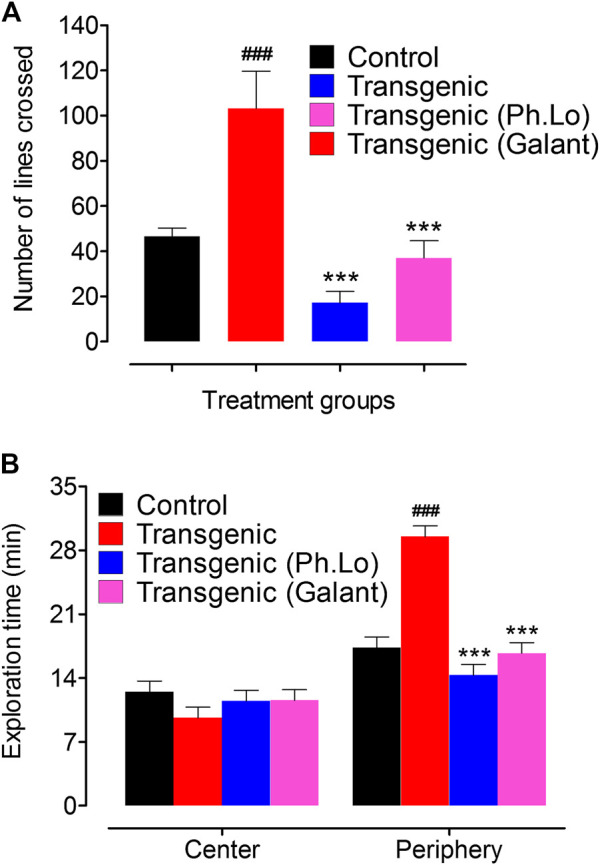
Effect of Ph. Lo in the open field test in various groups of animals. (A) Number of lines crossed by various group of animals. (B) Exploration times in minutes.